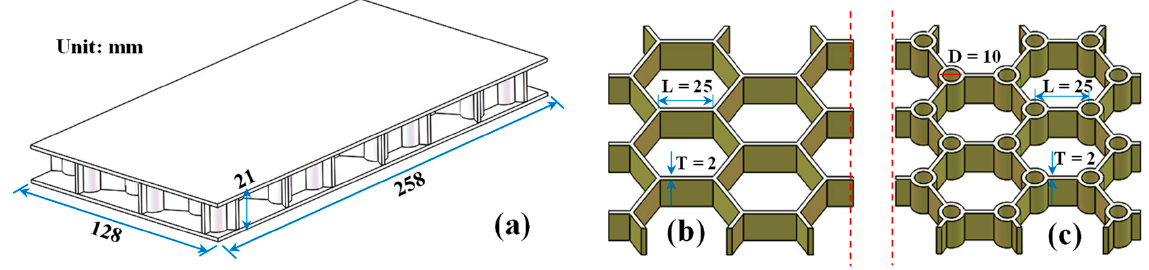
Figure 2. Structural size diagram of the sandwich plate. ( a ) Overall size (EBEP fc as an example); ( b ) EBEP fc core unit size; and ( c ) HP fc core unit size. No filling foam was displayed here.